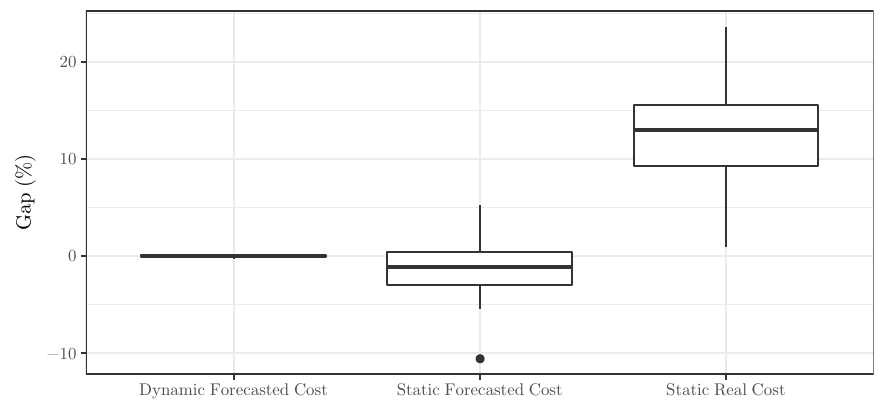
Figure 3. Multiple boxplots comparing the gaps of the different costs relative to the DRC with a uniformly distributed error term (cid:101) ∈ [ − 10 − 3 ,10 − 3 ]